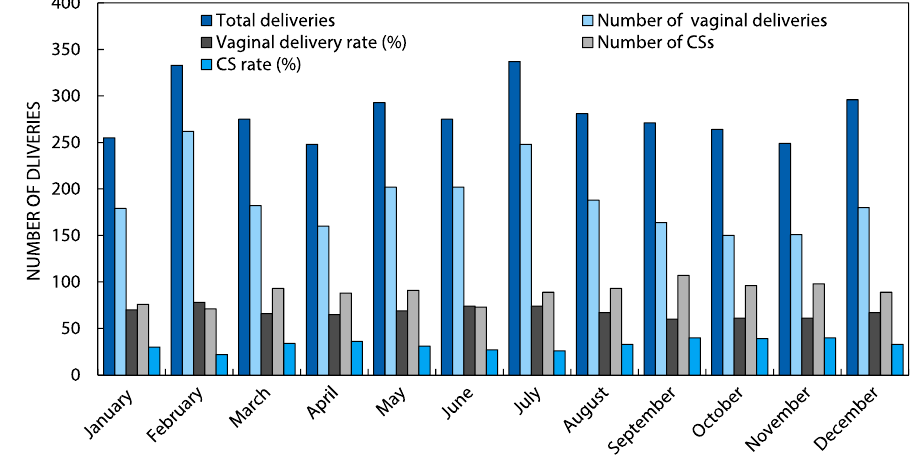
Figure 1: Monthly deliveries in